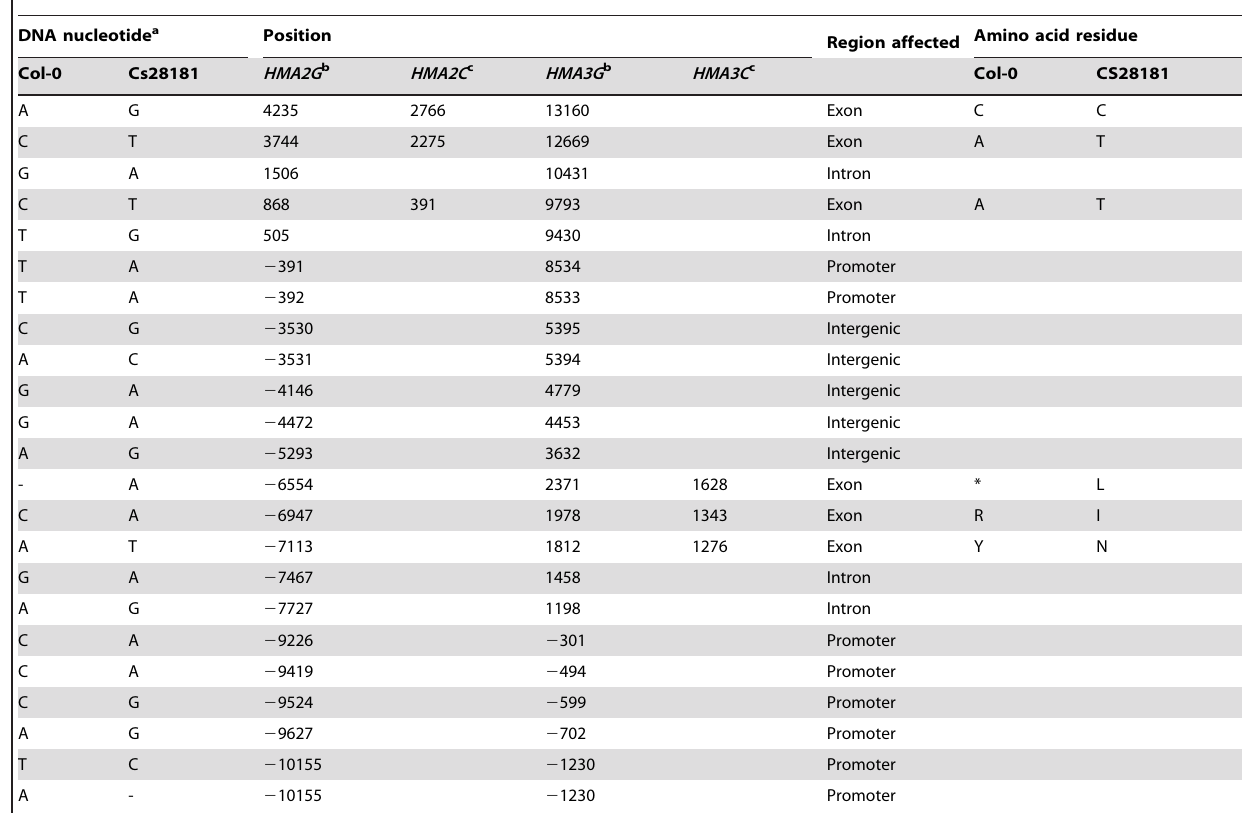
Table 2. Polymorphisms in A. thaliana HMA2 and HMA3 between Col-0 and CS28181.